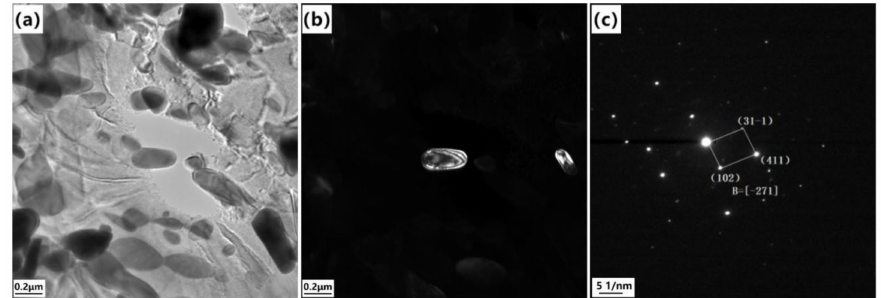
Figure 7. HRTEM images of precipitates at 75% strain: ( a ) bright field, ( b ) dark field, ( c ) diffraction pattern and